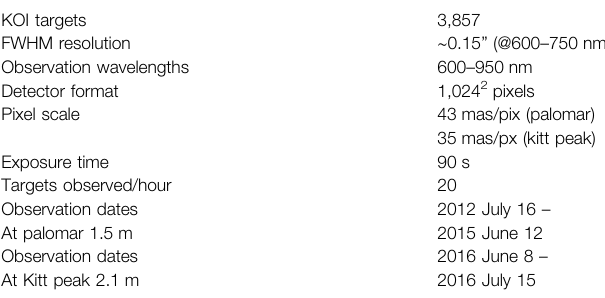
TABLE 1 | The speci fi cations of the Robo-AO KOI